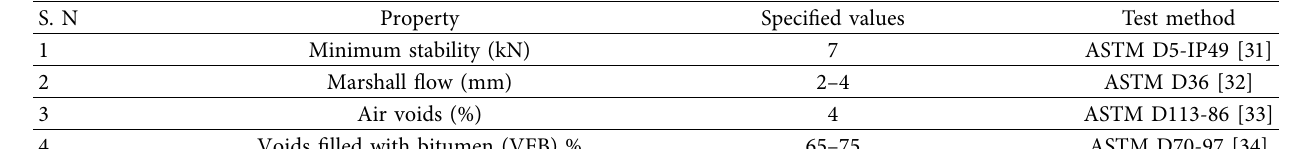
Table 6: Requirements for Bituminous pavement layers.